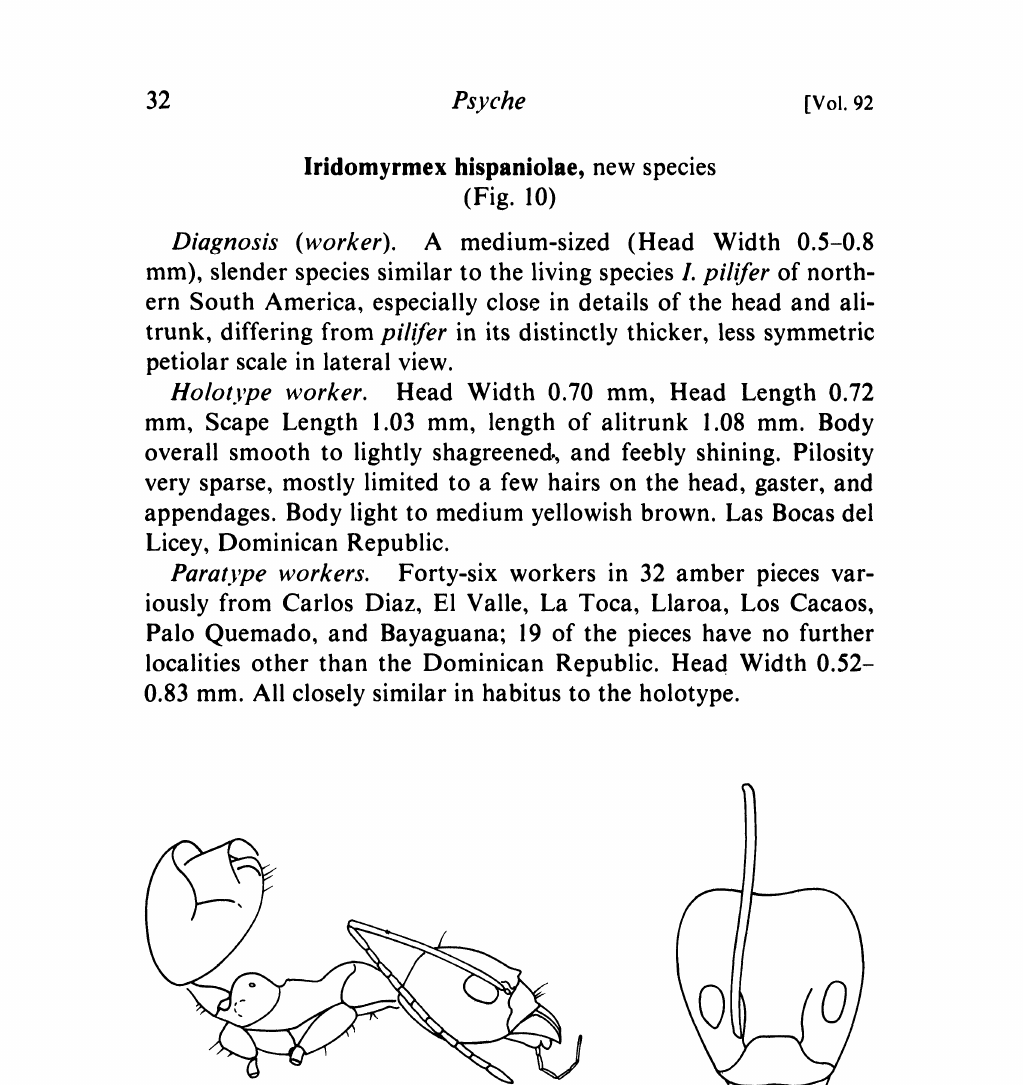
Fig. 10. lridom.vrmex hispaniolae holotype worker: A, side view of body;